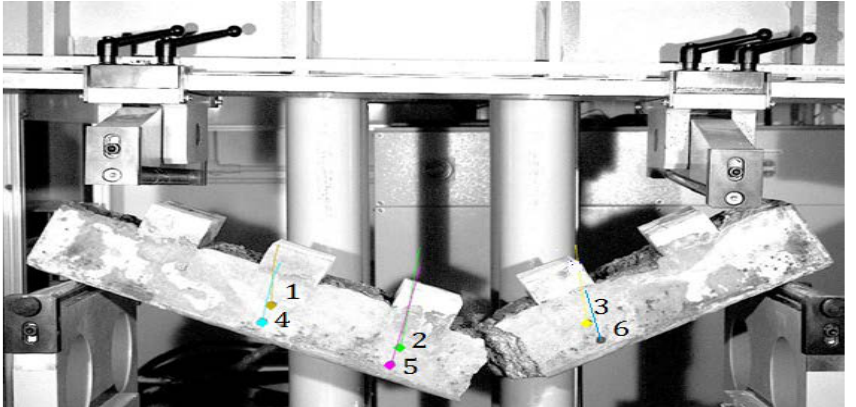
Figure 14. Sample after bending strength testing—dots were used to register the movement of the sample with the PHANTOM MICRO LC310 camera—not described in this article.